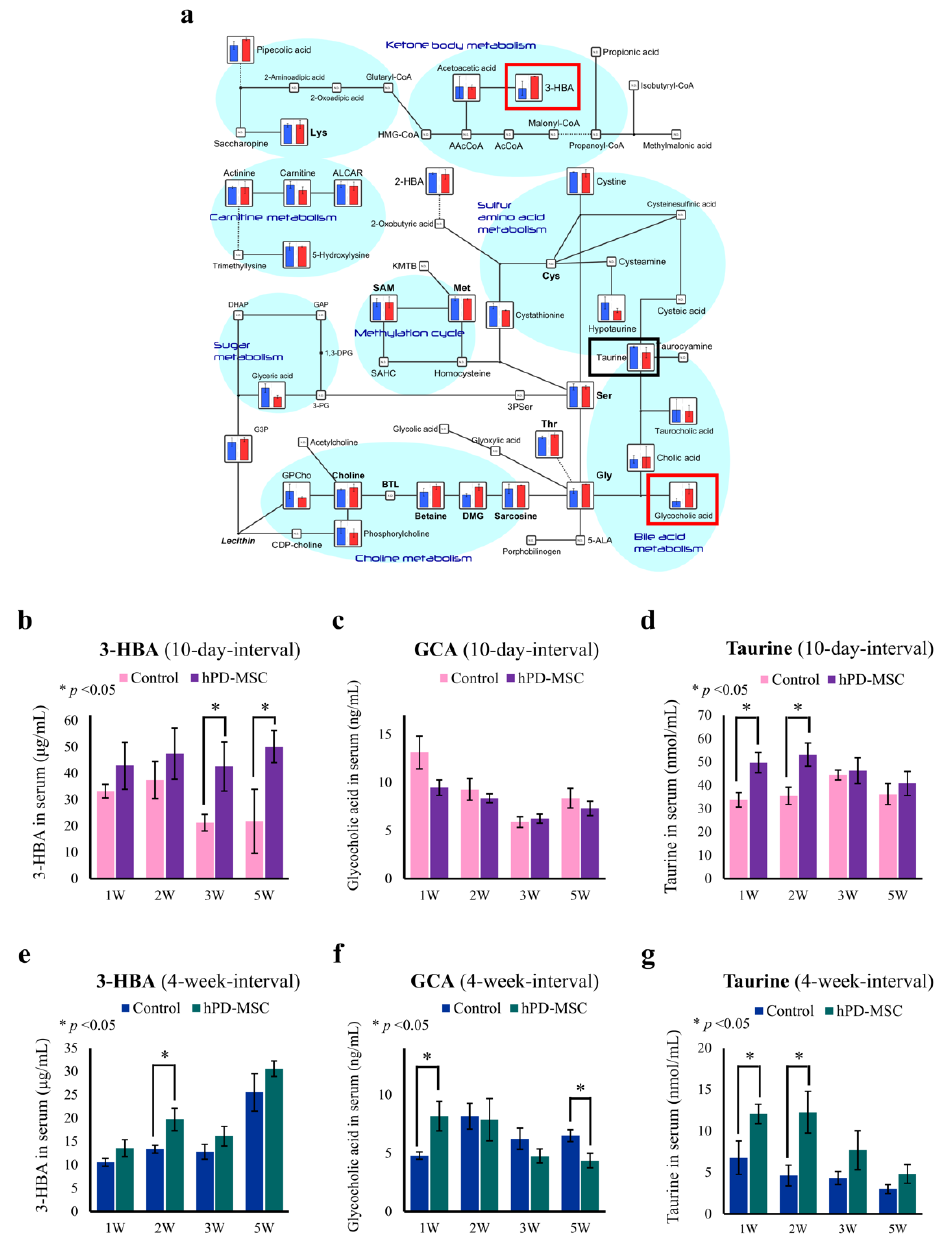
Figure 2. Multiple-injection hPD-MSC therapy is characterized by metabolic changes related to antiaging and extending lifespan. ( a ) The levels of intermediates of lipid and amino acid metabolism are plotted on pathway maps, and the relative quantities of the detected metabolites are shown as bar graphs. Blue bar, control group; red bar, multiple-injection hPD-MSC therapy group. ( b – g ) hPD-MSC therapy improves the serum levels of three antiaging metabolites. The levels of 3-HBA ( b , e ), glycocholic acid ( c , f ), and taurine ( d , g ) as determined by ELISA at various time points after multiple injections of hPD-MSC therapy at 10-day ( b – d ) or 4-week ( e – g ) intervals. Data are presented as the mean ± SEM. The asterisk represents statistical significance at p < 0.05. Control, PBS-injected group; hPD-MSCs, multiple-injection hPD-MSC therapy group.